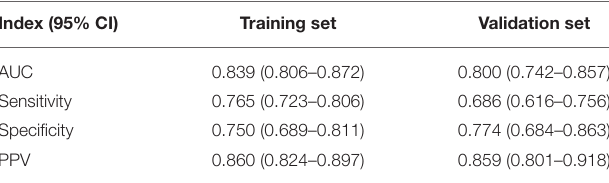
TABLE 3 | Features of the prediction model in the training and validation